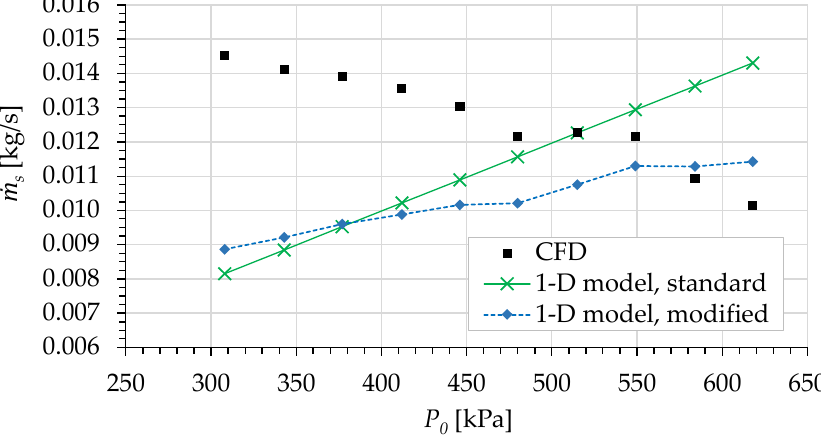
Figure 18. The secondary mass flow rates of ejector G2.1 obtained from various methods for different primary pressures.